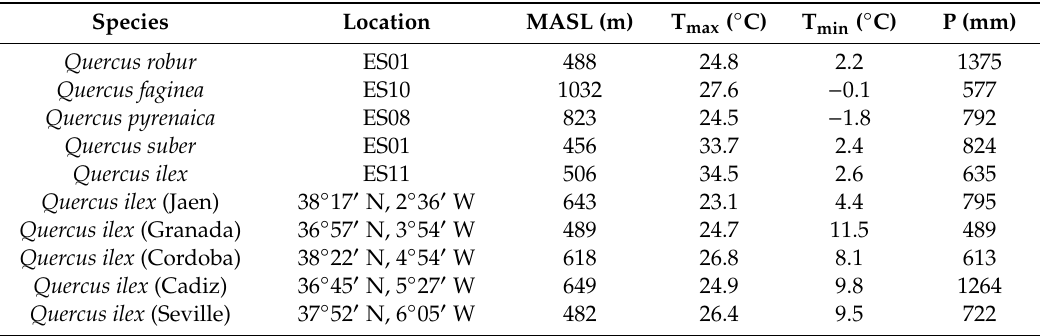
Table 1. Environmental features of the Quercus spp. and Andalusian Q. ilex populations used. Altitude (Meters Above Sea Level–MASL), average temperature of the coldest month (T min ), average temperature of the warmest month (T max ), and average annual rainfall (P) [29]. ES code indicates the region of origin as detailed in “ Centro Nacional de Recursos Gen é ticos Forestales, El Serranillo ”). Localization of all species is included in Figure S1. Species